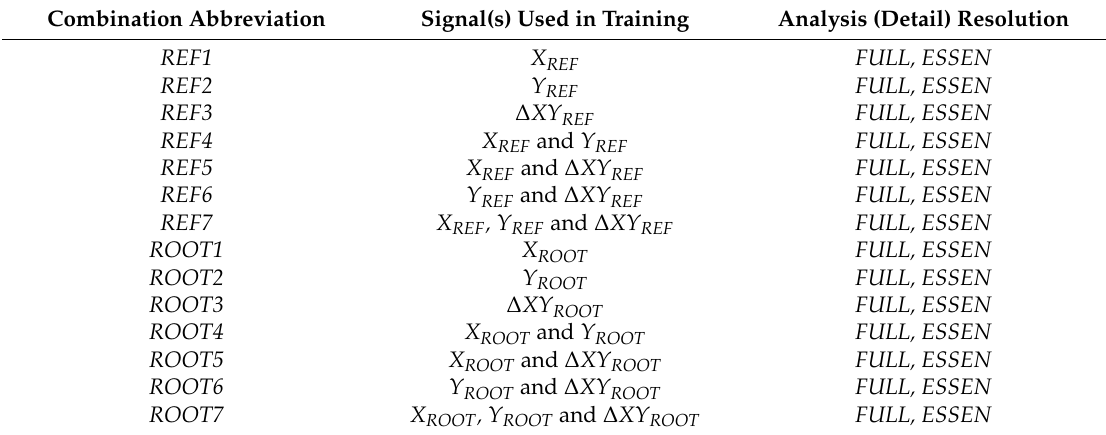
Table 3. Combinations, signals and analysis resolutions used in the training phase of the